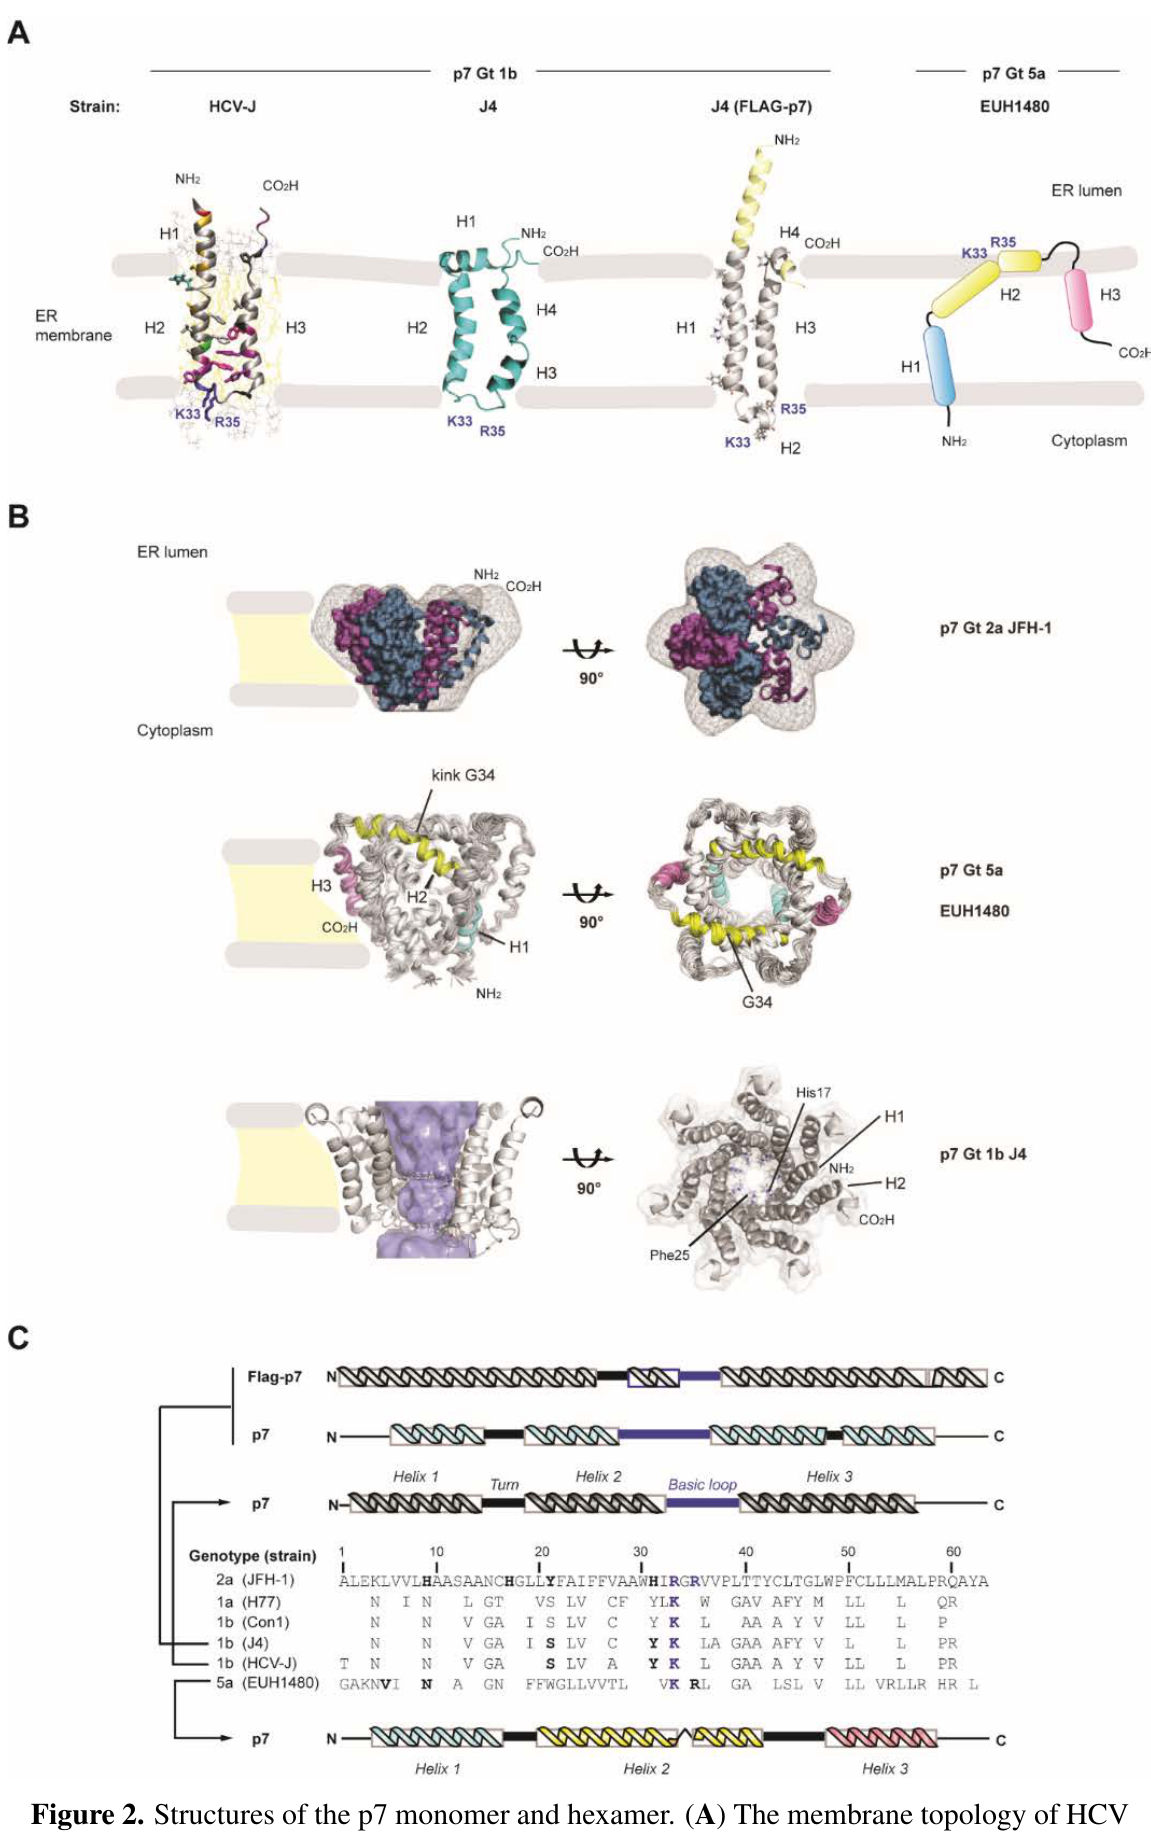
Figure 2. Structures of the p7 monomer and hexamer. ( A ) The membrane topology of HCV p7 Gt1b (HCV-J) as deduced from the NMR structure [17] is shown in the left.